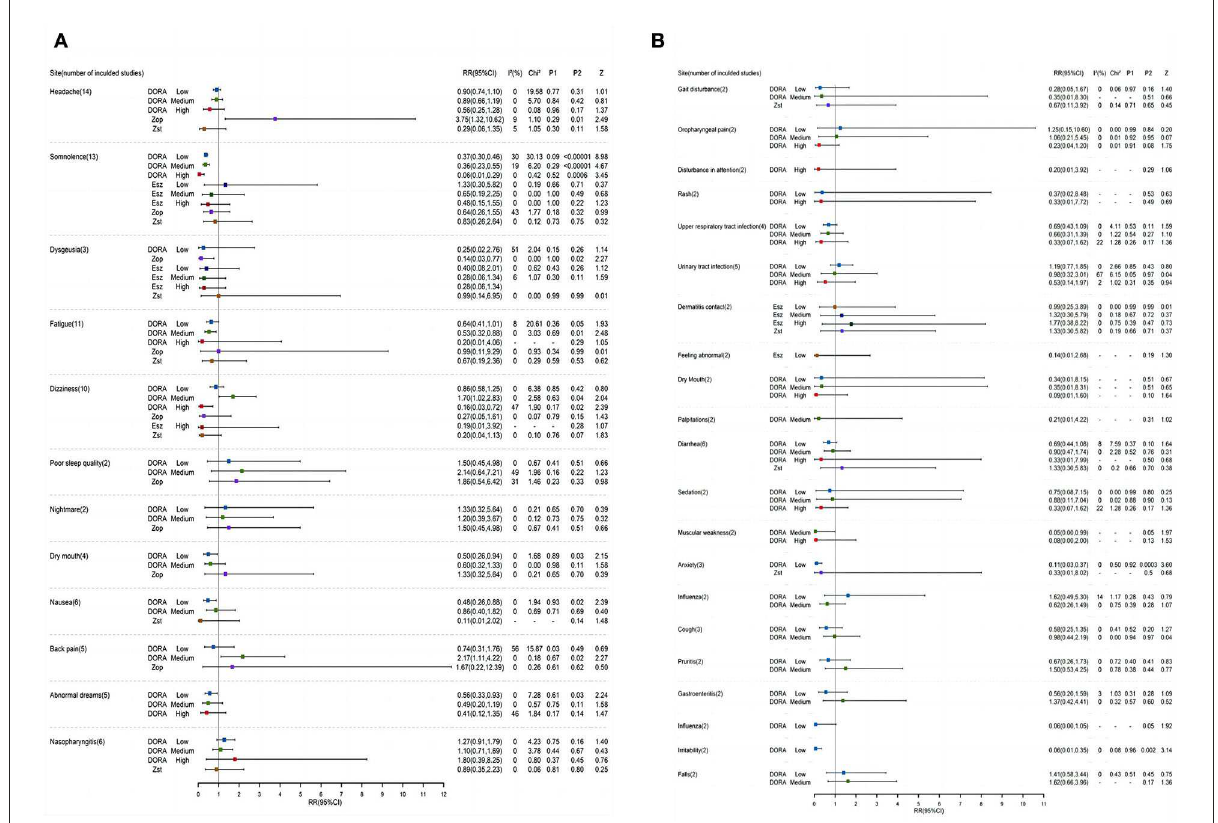
FIGURE5 (A,B) A Forest map of adverse reactions in DORA, zolpidem, zopiclone, and eszopiclone groups.